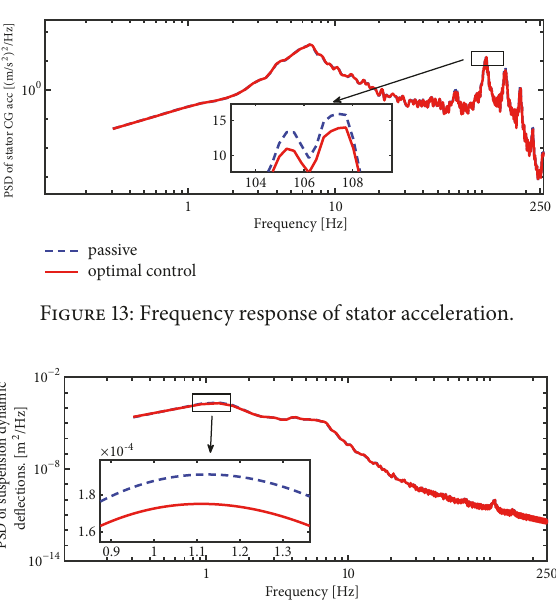
Figure 15: Frequency response of tyre deformation.